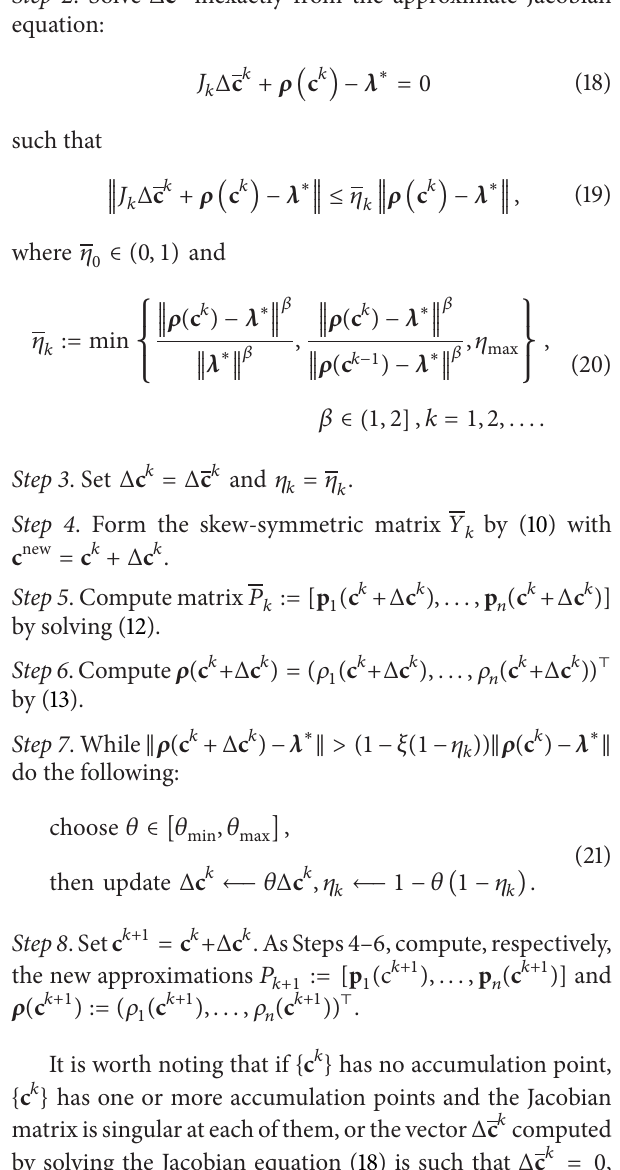
Algorithm 1 (Inexact Newton-Like Backtracking